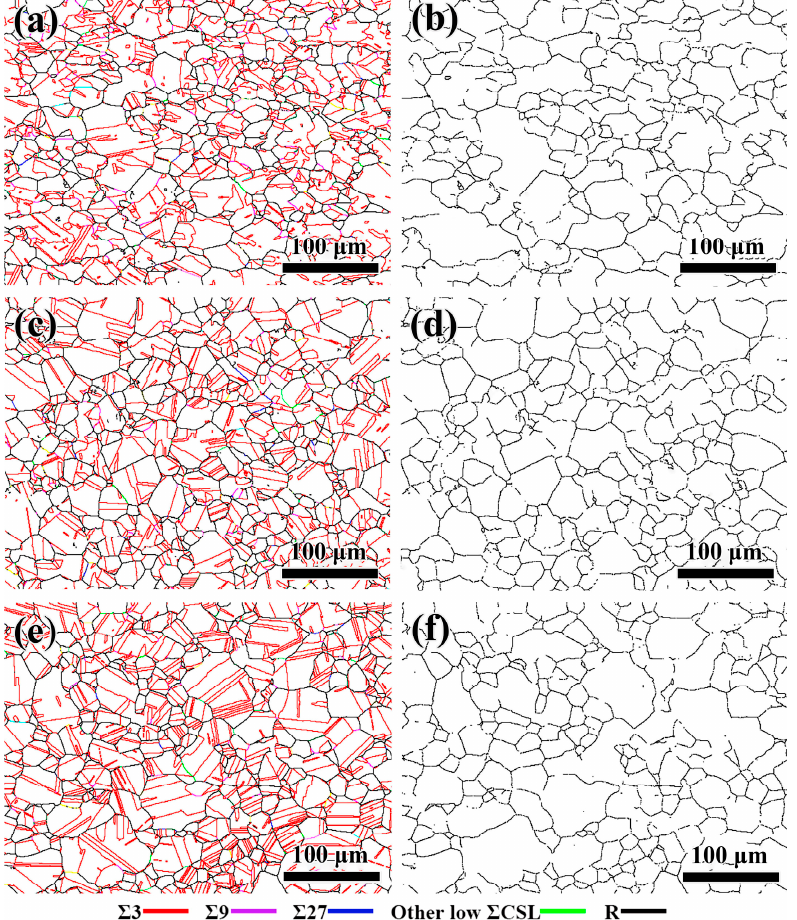
Figure 3. GBCD and corresponding RHAGB network maps of the BM samples: ( a , b ) Ni-5at.%Cr; ( c , d ) Ni-20at.%Cr; ( e , f ) Ni-40at.%Cr.